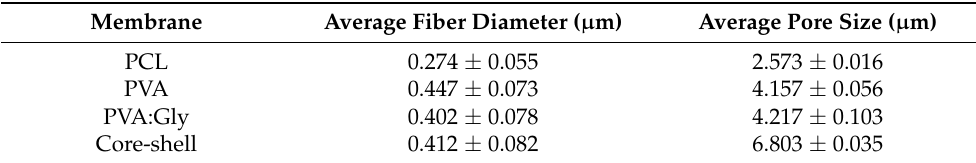
Table 2. Average fiber diameter and pore size of each fabricated membrane.